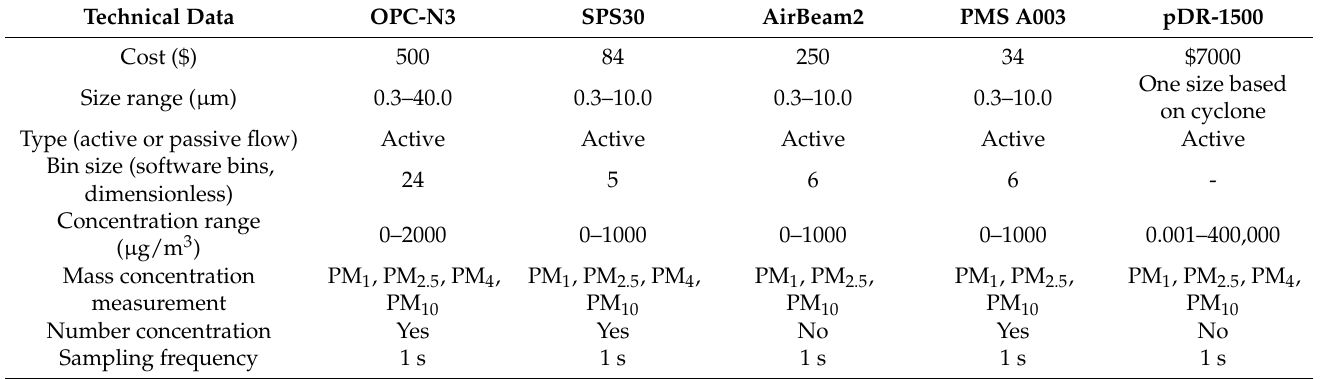
Table 1. Specifications of the low-cost OPCs and